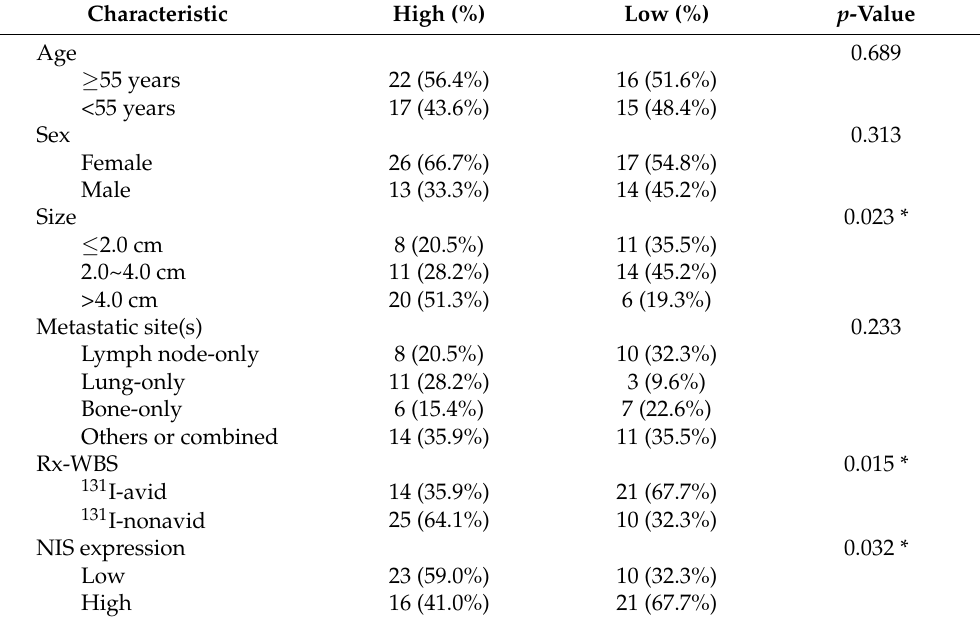
Table 1. Clinicopathological features of patients with metastatic papillary thyroid cancer according to the expression of IGF2BP2 ( n = 70). Characteristic High (%) Low (%) p